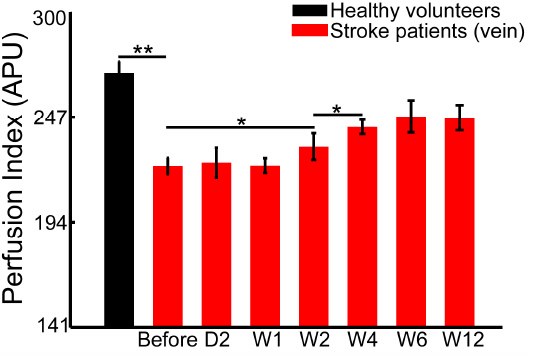
Figure 4. Statistical analysis of the superficial blood flow signal in hand veins of healthy volunteers and stroke patients (* p < 0.05; ** p < 0.01).